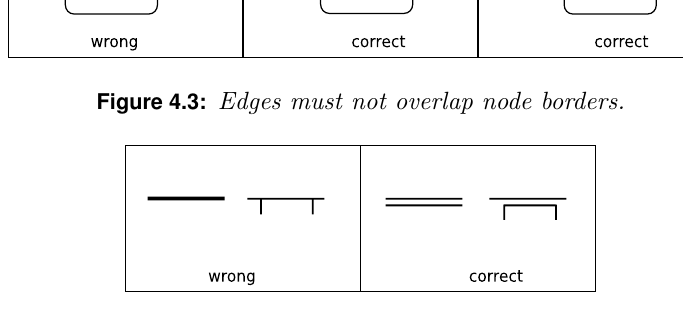
Figure 4.4: Edges must not overlap.